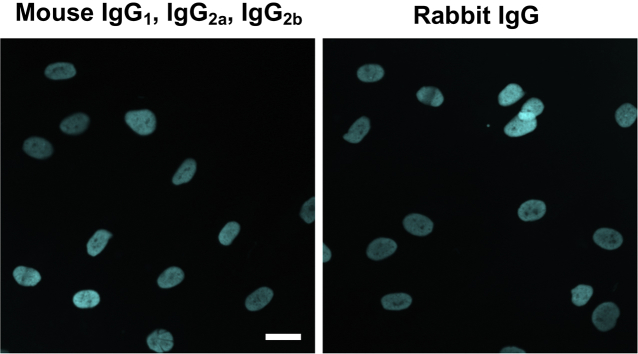
Isotype control staining of patient-derived tendon stromal cells. Representative confocal immunofluorescence images showing merged images of stromal cells isolated from patients with shoulder tendon tears, stained with isotype control antibodies for mouse IgG1, IgG2a, IgG2b, and rabbit IgG fractions. Cyan represents POPO-1 nuclear counterstain. Scale bar = 20 μm.